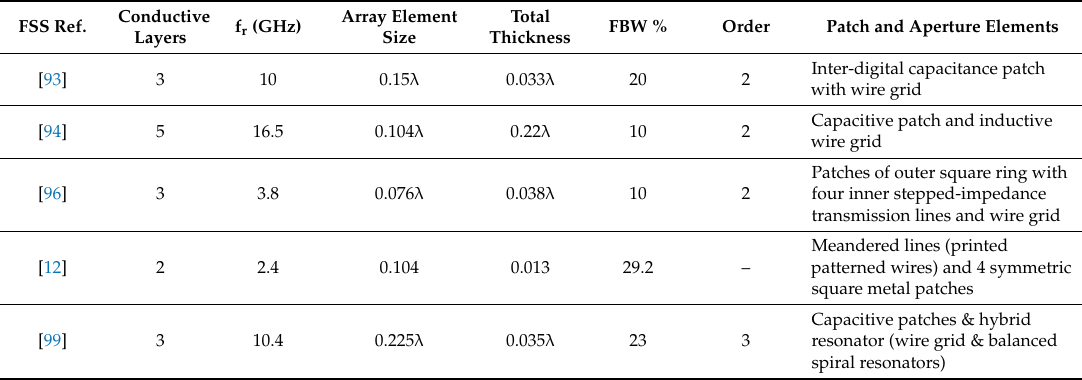
Table 4. Different multilayer